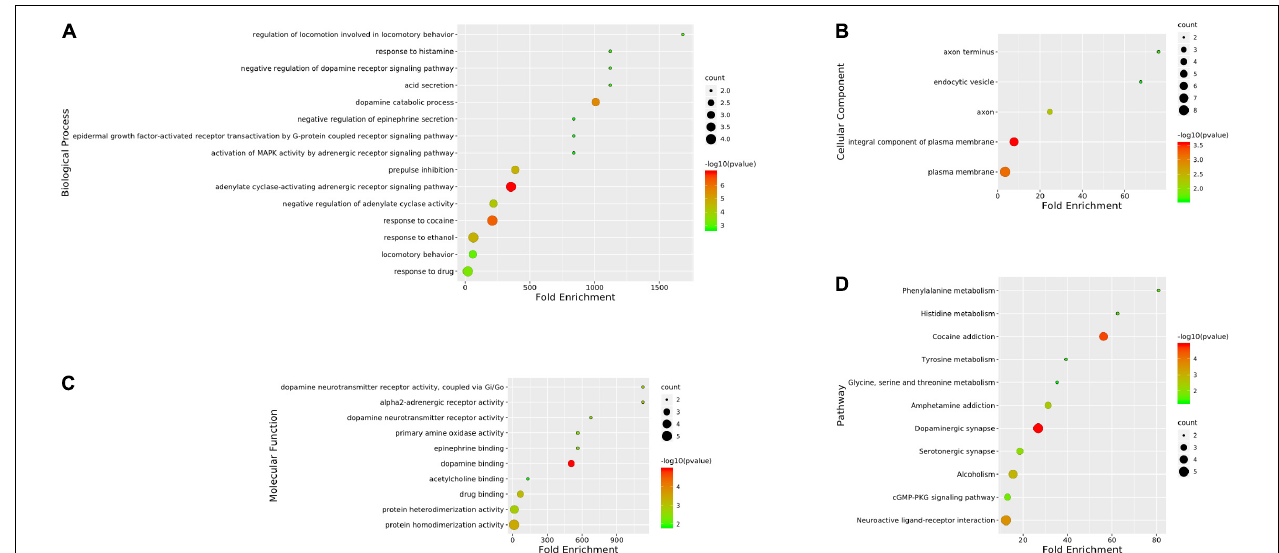
FIGURE 6 | Gene ontology (GO) analysis and kyoto encyclopedia of genes and genomes (KEGG) enrichment of hub targets of candidate Chinese herbal medicine (CCHM) in the treatment of methamphetamine (METH) addiction. (A) The top 15 significantly enriched terms in BP enrichment analysis of the hub genes. (B) The top five significantly enriched terms in CC enrichment analysis of the hub genes. (C) The top 10 significantly enriched terms in MF enrichment analysis of the hub genes. (D) The top 11 significantly enriched terms in KEGG enrichment analysis. Counts refer to the number of the enriched genes. TABLE 4 | Results of kyoto encyclopedia of genes and genomes (KEGG) analysis on hub targets of candidate Chinese herbal medicine (CCHM) in the treatment of methamphetamine (METH) addiction. Pathway Counts Genes Dopaminergic